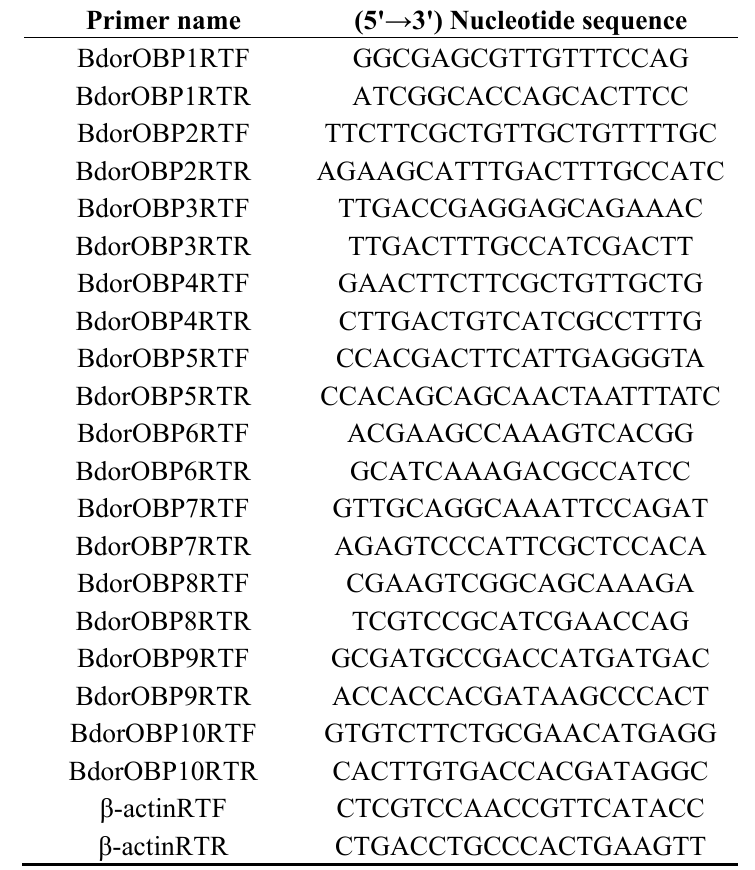
Table 2. Primers used for gene expression detection of BdorOBPs by